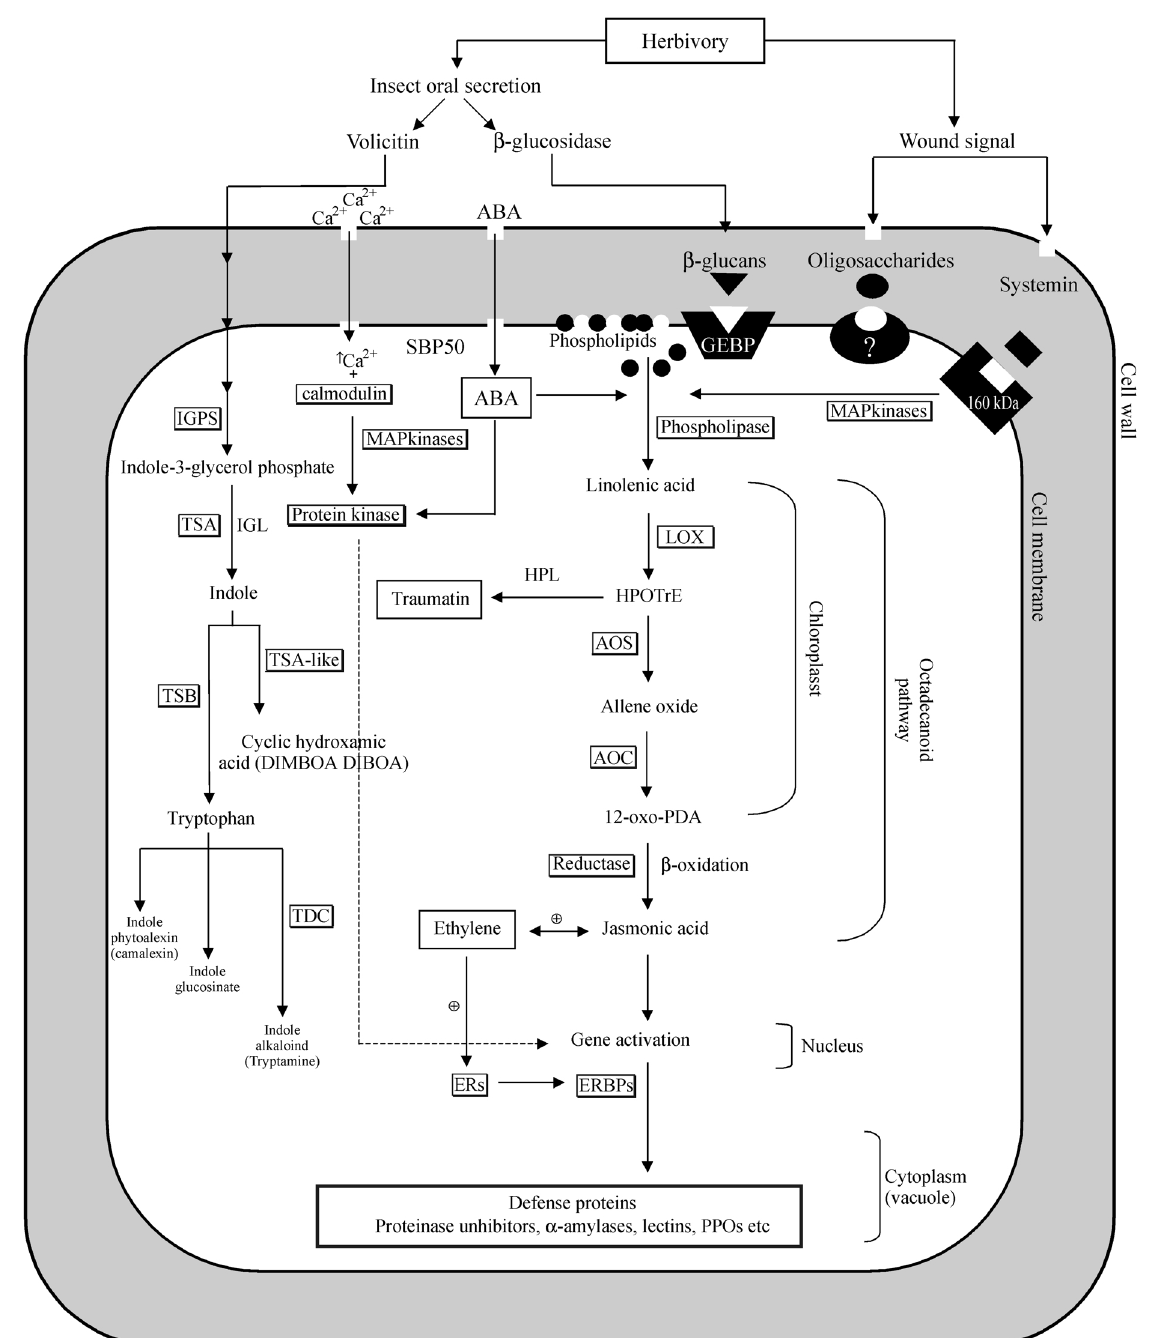
Figure 1 - Putative intracellular wound signal transduction pathway leading to the induction of defense protein gene expression. The pathway is initiated by the interaction of local or systemic signal molecules and putative plasma membrane receptors. Wound signal molecules include oligogalacturonic acid, chitosan, physical signals, abscisic acid (ABA) and systemin. Plasma membrane receptors include a β -glucan-elicitor-binding protein (GEBP), a systemin-binding protein of 160 kDa, and an unidentified receptor for oligosaccharide elicitors. Filled arrows illustrate portions of the pathway proposed from direct evidence. Broken arrows illustrate inferred pathways or interations. Blue boxes indicate orthologous present in sugarcane. A lipase translates the wound signal and releases linolenic acid from membrane phospholipids, a process stimulated by ABA. Volicitin and β -glucosidase from the oral se- cretion of insects may also function like linolenic acid, i.e. be converted to jasmonic acid through the octadecanoid pathway. Key: LOX = lipoxygenase; HPL= hydroperoxyde lyase; AOS = allene oxide synthase; AOC = allene oxide cyclase; SA = salicylic acid; HPOTrE, = 13(S)-hydroperoxylinolenic acid; 12-oxo-PDA = 12-oxo-phytodienoic acid; IGP = indole-3-glycerol phosphate; IGPS = indole-3-glycerol phosphate synthase; TSA = tryptophan synthase-subunit- α (BX1 in maize) (a constitutive enzyme which catalyzes the conversion of IGP to indole); IGL = indole-3-glycerol phosphate lyase (induced in response to herbivore damage in maize); DIMBOA = [2,4-dihydroxy-7-methoxy-2 H -1,4-benzoxazin-3(4 H )-one] and DIBOA = [2,4-dihy- droxy-1,4-benzoxazin-3-one] (defense-related secondary metabolites); TSB = tryptophan synthase-subunit- β ; TSA-like = tryptophan synthase- α -like protein (BX2-7 in maize) (enzymes necessary for the conversion of indole to DIMBOA and DIBOA); TDC = tryptophan decarboxylase. ERBPS = ethyl- ene-responsive binding. See text for